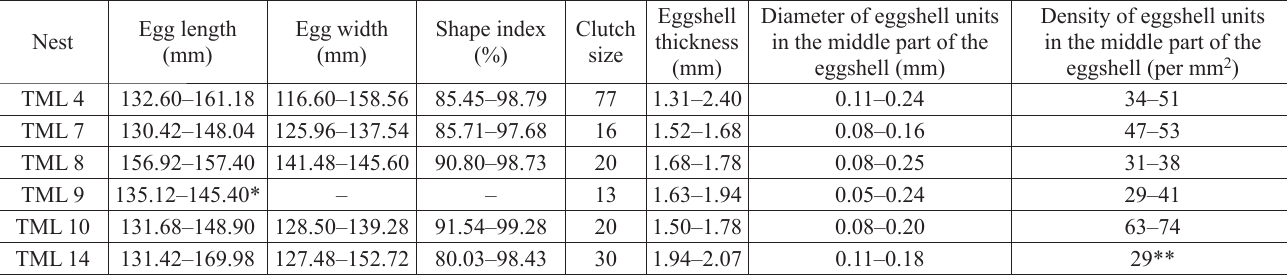
Table 1. Measurements of the dendroolithid eggs Placoolithus tumiaolingensis . *All eggs are partially exposed, only one parameter (diameter) can be measured. **The density of eggshell units is from a single tangential